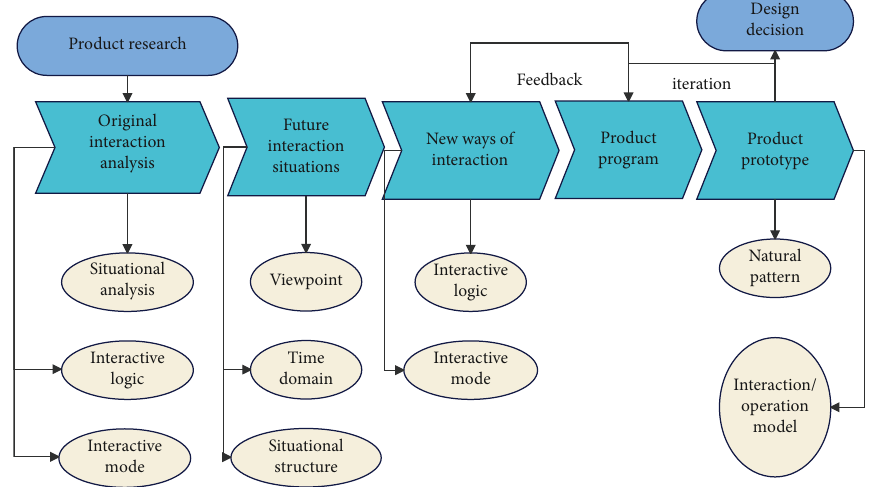
Figure 11: Interactive product design program.